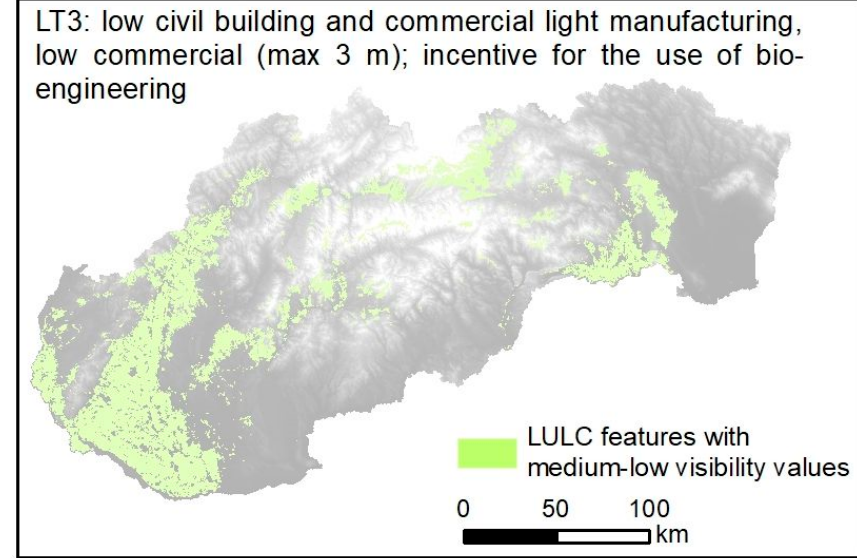
Figure 9. Maps of the different proposed norms: LT3.